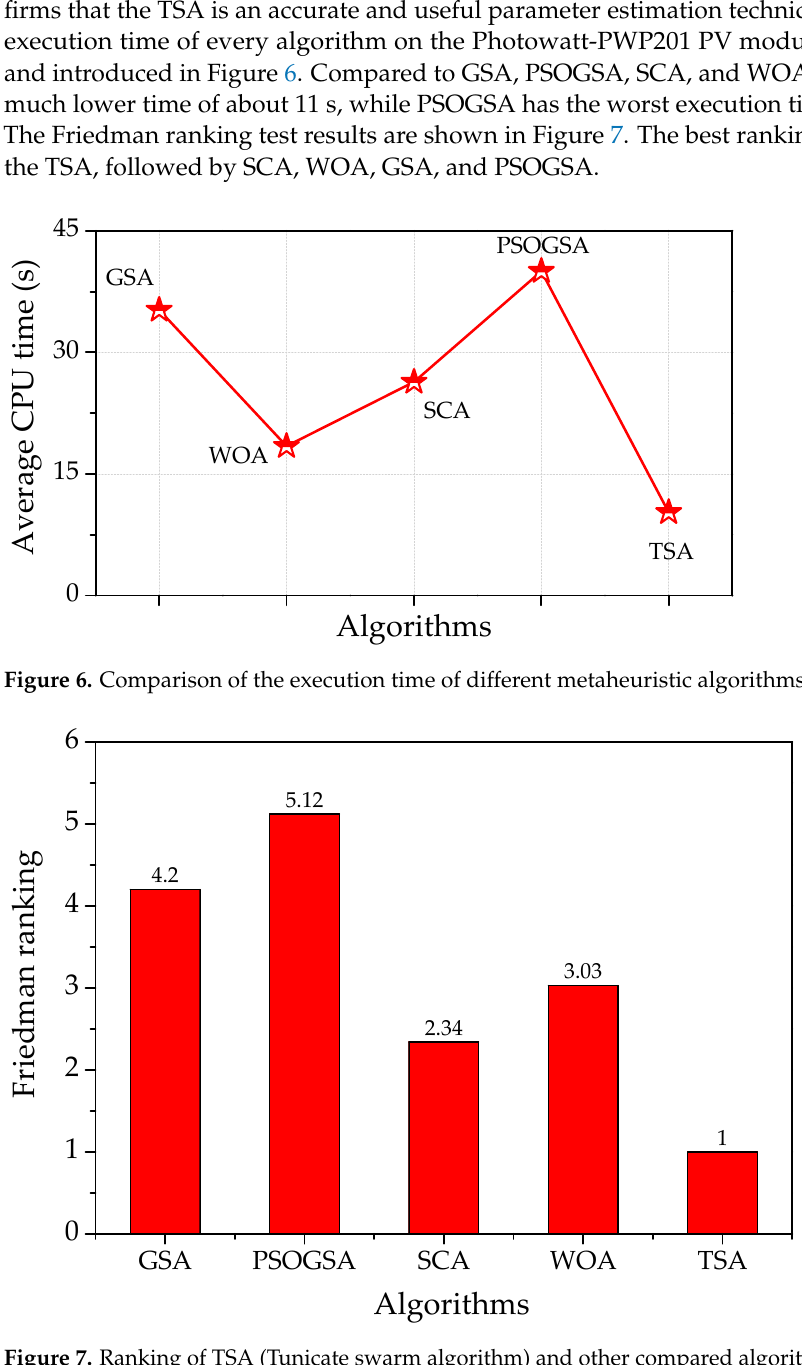
Figure 7. Ranking of TSA (Tunicate swarm algorithm) and other compared algorithms on Photowatt-PWP201 PV panel module according to the Friedman test.